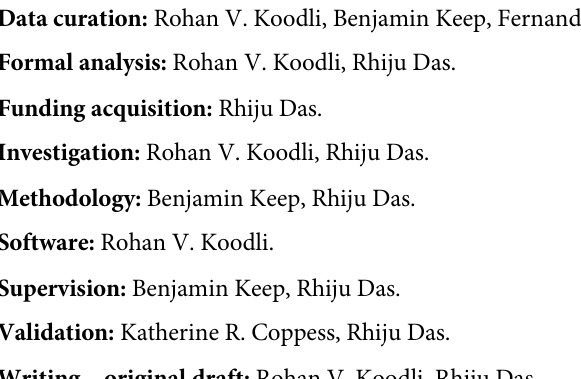
S3 Fig. Training the EternaBrain convolutional neural network on eternamoves-select . (A) Cross-validation accuracy of location predictor per epoch of training. (B) Cross-validation accuracy of base predictor per epoch of training. An epoch of training is one complete pass of backpropagation, retraining, and receiving feedback of performance over all 30,447 solutions (305 mini-batches of 100 solutions each). S4 Fig. Time and number of moves of EternaBrain-SAP compared to Eterna human play- ers. (A) Median time and (B) number of moves needed to solve Eterna100 puzzles. Puzzles that were only solvable by Eterna human players are not shown. S1 Table. Hyperparameter search for neural net architecture. S2 Table. Number of solutions and moves for top players used in eternamoves-select